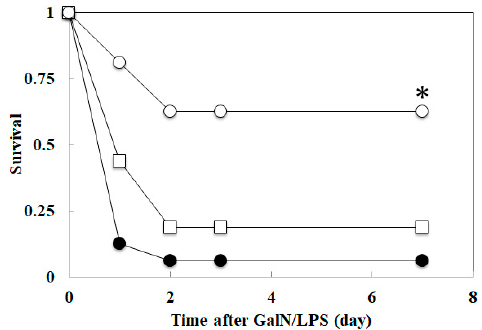
Figure 1. Effect of levosimendan on survival in D-galactosamine hydrochloride and lipopolysaccha- ride (GalN/LPS) rats. A mixture of 500 mg/kg GalN and 2.5 µg/kg LPS (GalN/LPS) was injected via the penile vein. The curves are plotted survival rate at 1, 2, 3, and 7 days. The survival rate in the positive control group ( filled circle ), the pretreatment group of levosimendan 2 mg/kg ( square ), or 4 mg/kg ( open circle ). * p < 0.05 compared with the positive control group by log-rank test.